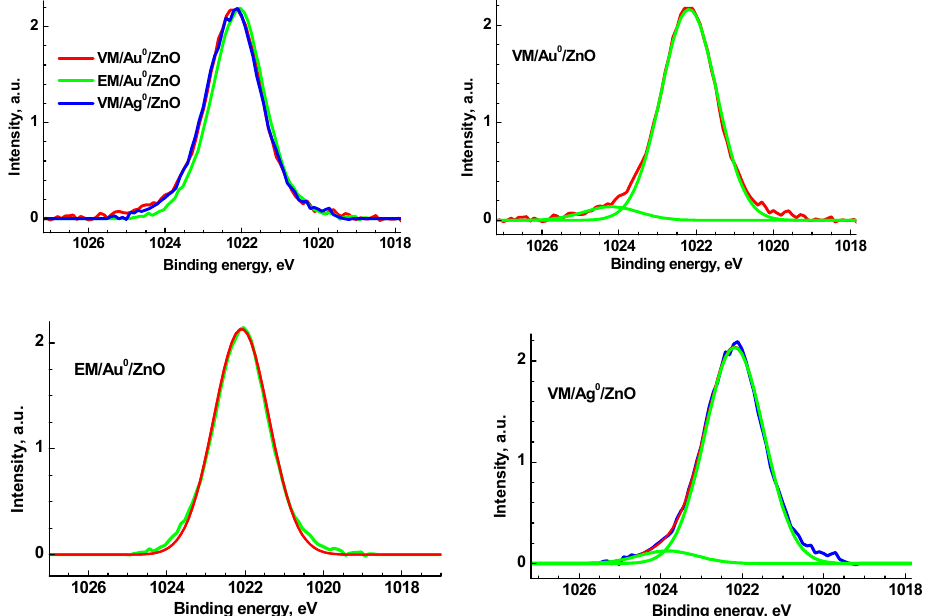
Figure 7. The Zn 2p 3/2 high-resolution spectra of the VM/Au 0 /ZnO, EM/Au 0 /ZnO, Figure 7 . The Zn 2p 3/2 high-resolution spectra of the VM/Au 0 /ZnO, EM/Au 0 /ZnO, and VM/Ag 0 /ZnO samples.